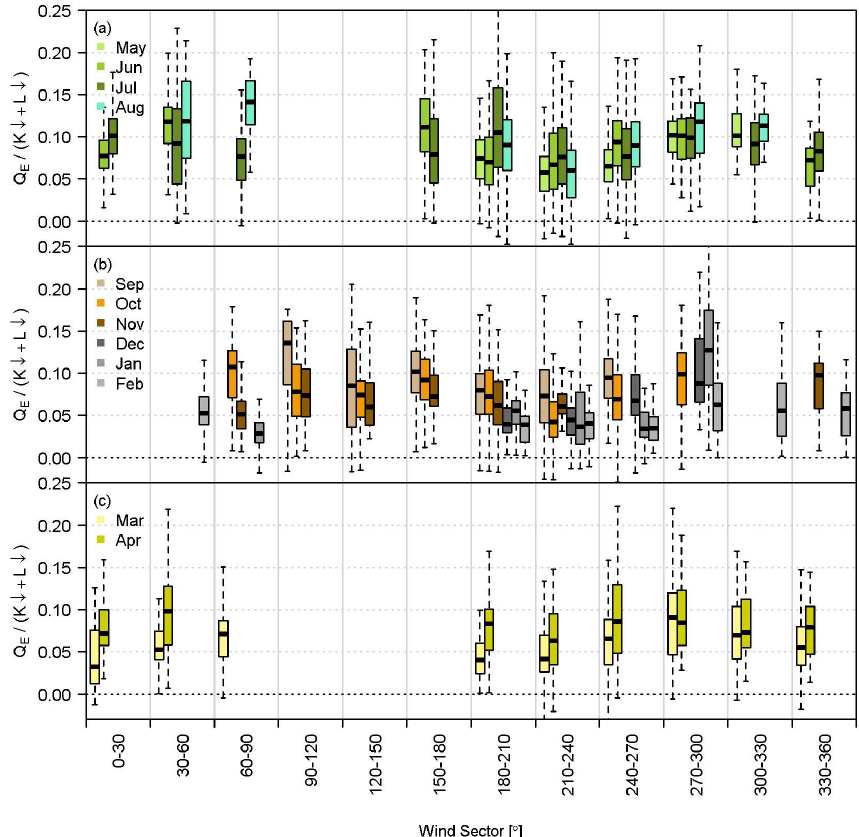
Fig. 16. As for Fig. 15 but for Q E normalised by incoming